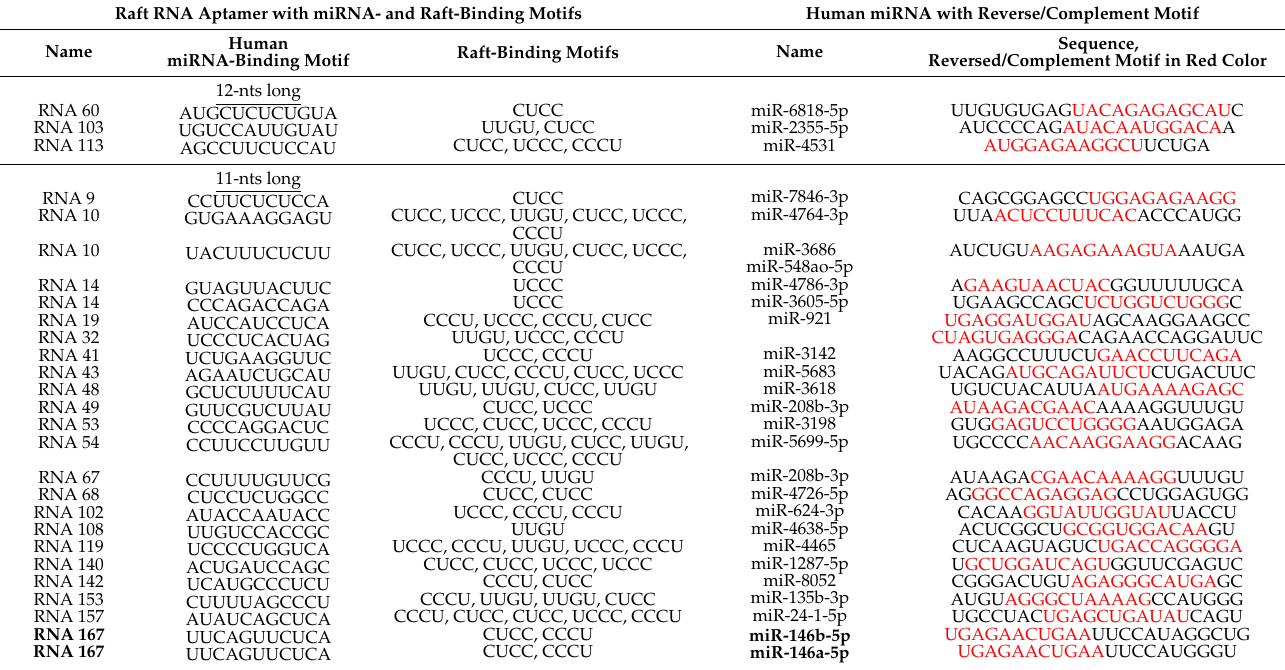
Table 3. Raft-RNA aptamers containing both miRNA- and raft-binding motifs with corresponding human miRNAs containing reversed/complement